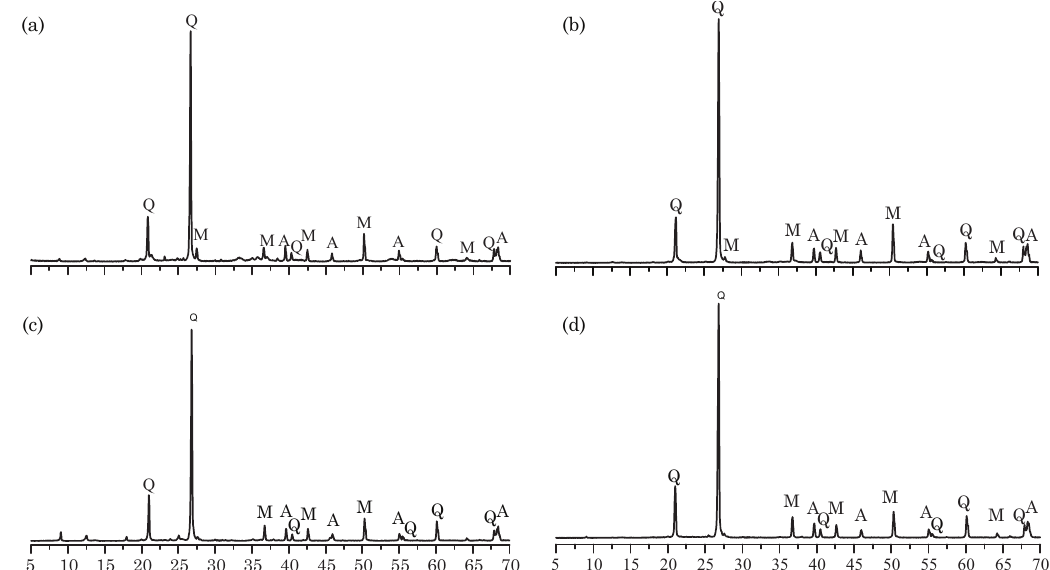
Figure 8. Diffractograms (°2 θθθθθ CuK ααααα ) of sand in AP1: (a) 30-75 cm, (b) 145-200 cm), and silt in AP10: (c) 105- 150 cm, (d) 170-200 cm, in horizons before (b, d) and after (a, c) the avulsion process. Q=Quartz, M=Mica,